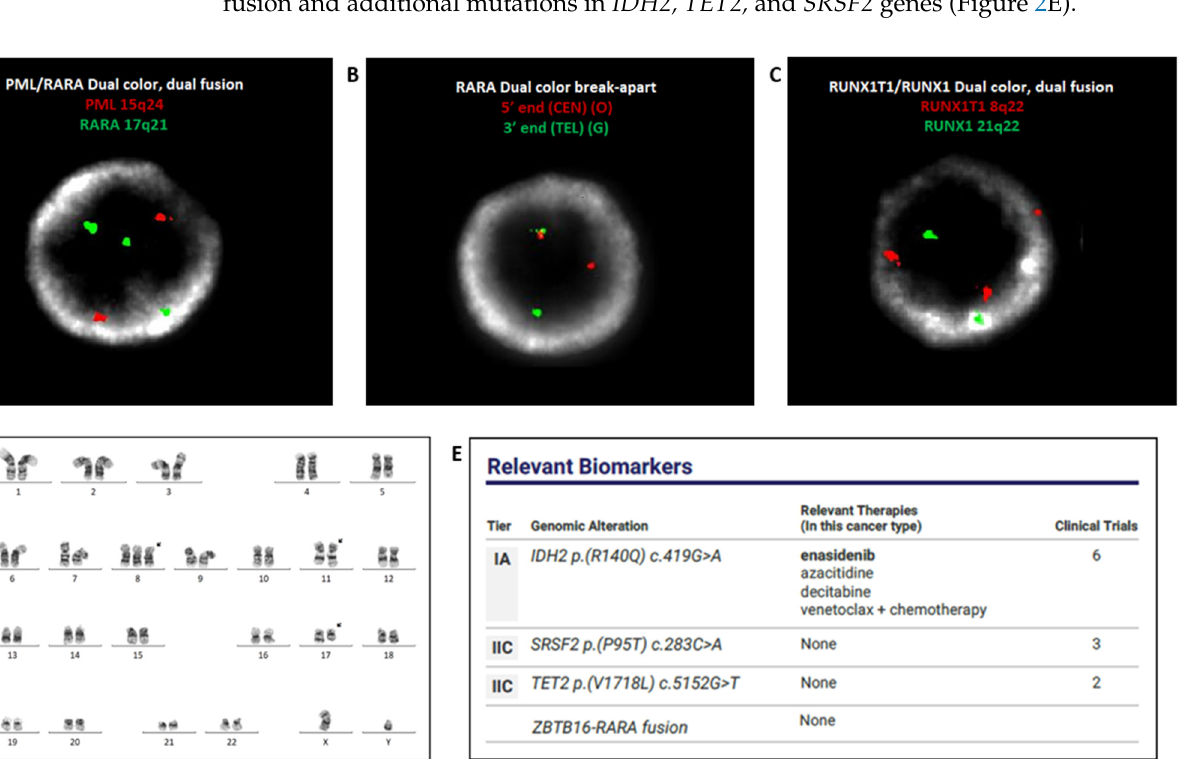
Figure 2. FISH with PML::RARA dual-color dual-fusion probes, negative for PML::RARA fusion, displaying three RARA (green) signals ( A ). FISH with RARA dual color break-apart probes displaying split signal, indicative of RARA rearrangement ( B ). FISH with the AML panel exhibiting three red signals for the pericentromeric region of chromosome 8 ( C ). Chromosome analysis identified gain of chromosome 8 and an (11;17) translocation. ISCN: 47,XY,+8, t(11;17)(q23;q21) ( D ). NGS analysis detected ZBTB16::RARA fusion and mutations in IDH2, TET2, and SRSF2 genes ( E ).